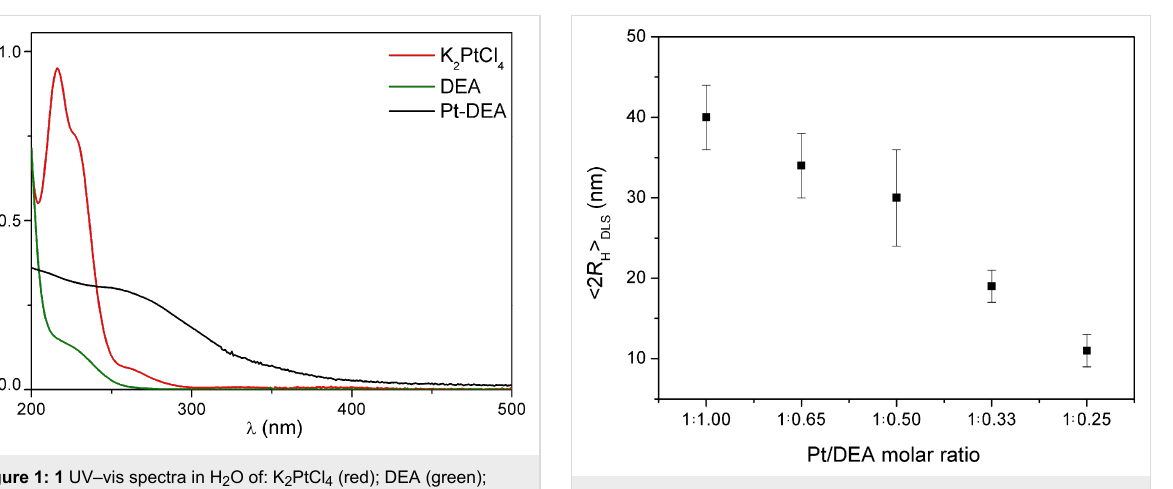
As the NaBH 4 reducing agent is added, the peak at 220 nm decreases and disappears within 30 min, indicating that the [PtCl 4 ] 2 − ions are completely reduced in 30 min according to Equation 1.